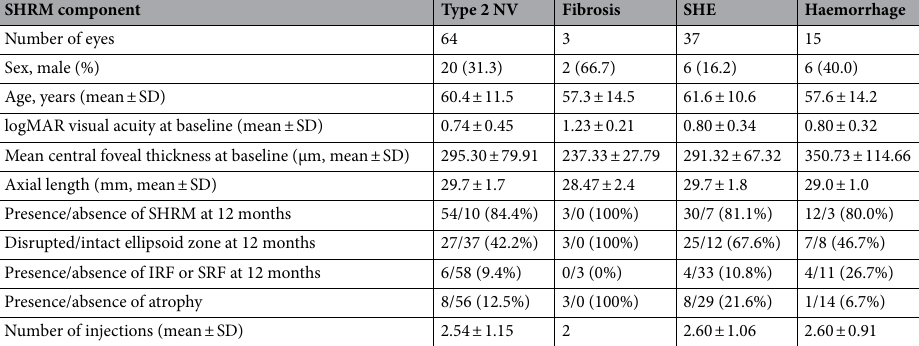
Table 2. Differences in the characteristics of the eyes according to the SHRM components. SHRM subretinal hyperreflective material, SD standard deviation, IRF intra-retinal fluid, SRF subretinal fluid, NV neovascularization, SHE subretinal hyperreflective